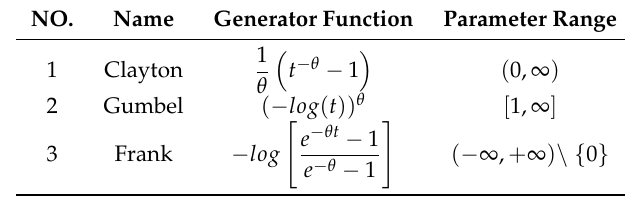
Table 2. Generator functions and parameter ranges of selected Archimedean